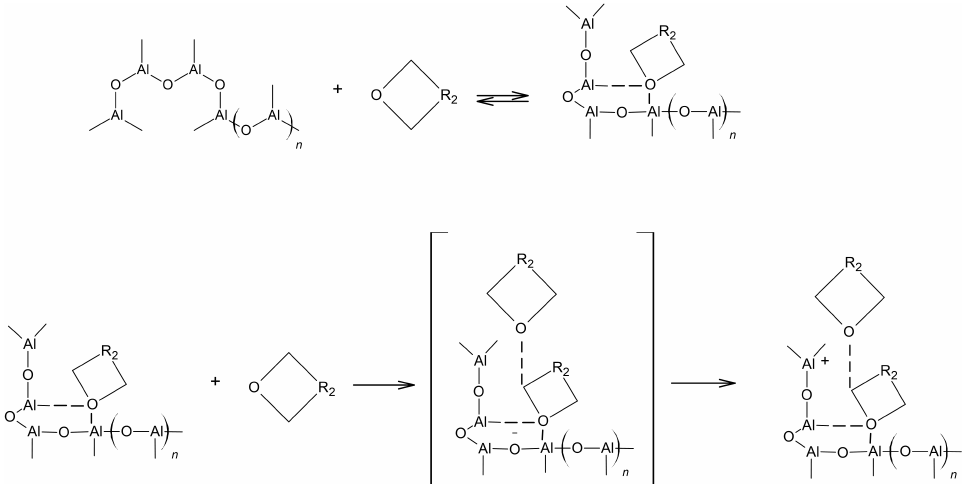
Figure 3. Mechanism of the initial reaction steps for the aluminium-catalysed ring opening polymeri- sation of oxetanes.